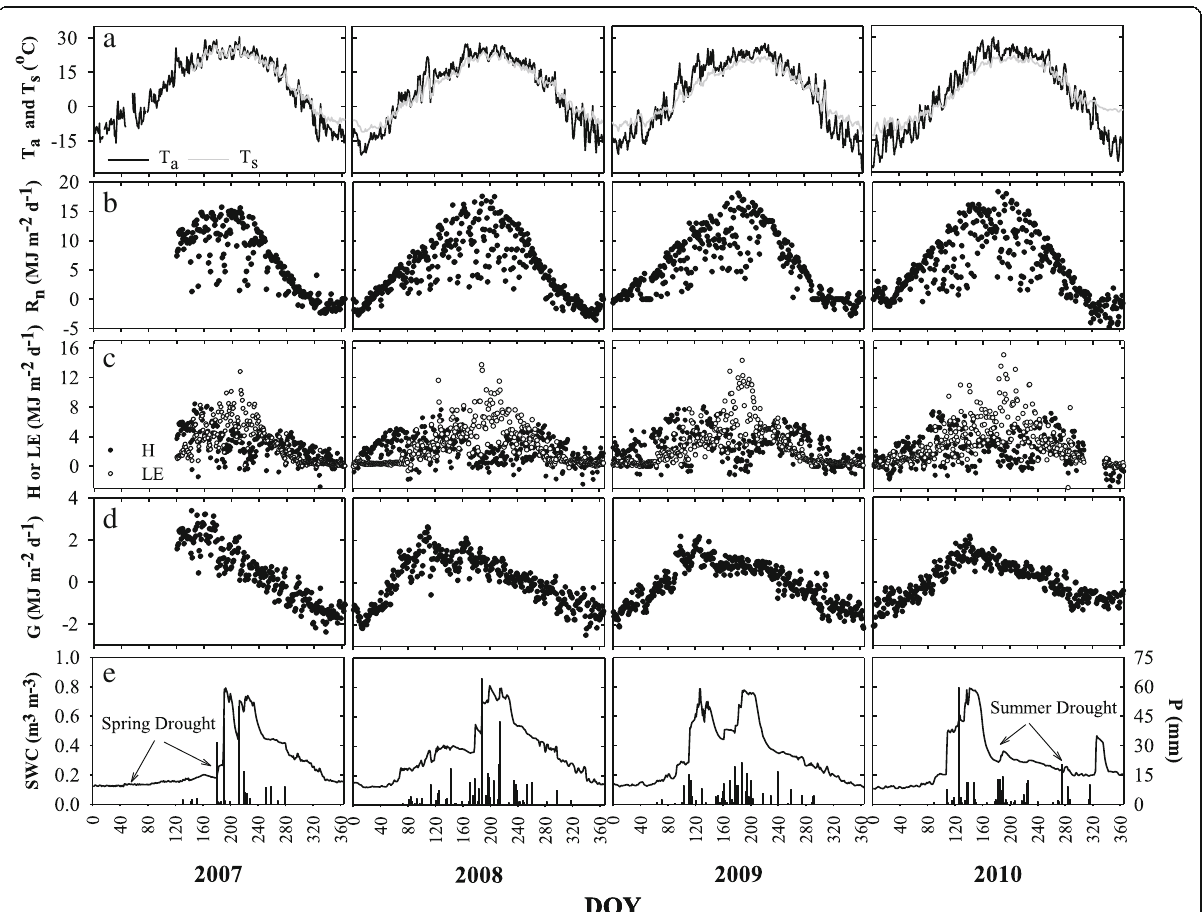
Fig. 1 Seasonal changes of major meteorological variables and energy fluxes during 2007 – 2010 in the meadow steppe: a daily mean air ( T a ) and soil ( T s ) temperatures, b net radiation ( R n ), c latent heat (LE) and sensible heat ( H ), d soil heat flux ( G ), and e daily mean soil volumetric water content (SWC) and daily sum of rainfall ( P